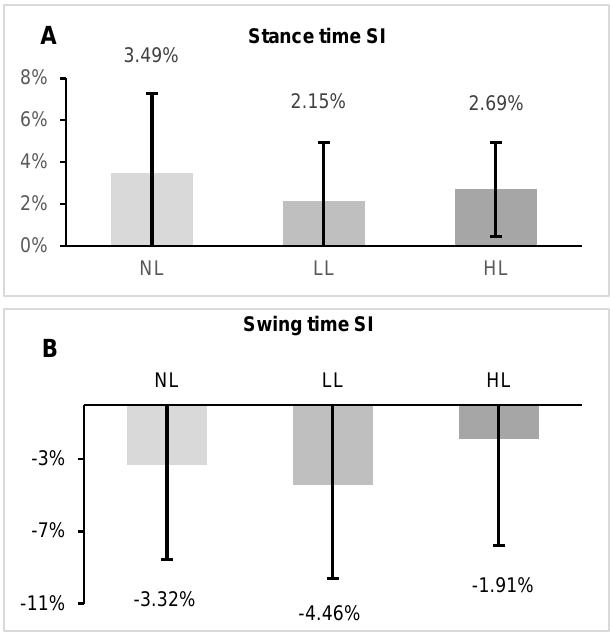
Figure 2: Mean stance time SI (A) and swing time SI (B) across the three load conditions. Error bars represent  1 SD. Negative SI values indicate that intact side values were higher. NL= No load, LL= Light load, HL= Heavy load.